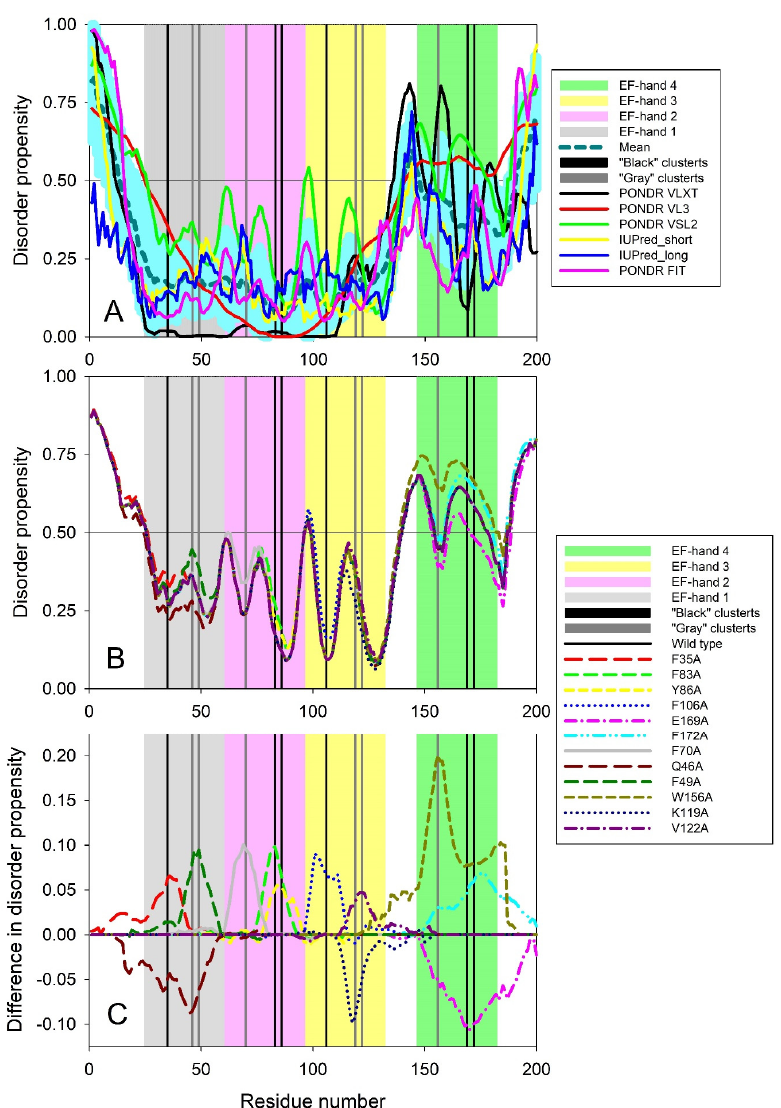
Figure 11. Intrinsic disorder predisposition of human recoverin ( A ) and effect of cluster mutations on intrinsic disorder propensity of this protein ( B , C ). In all plots, positions of four EF-hand motifs, residues 25–60, 61–96, 97–132, and 147–182 are shown by light gray, light pink, light yellow and light green bars, respectively. Positions of all mutations in ‘black’ and ‘gray’ clusters are shown by black and gray bars, respectively. Plot A shows results of a multiparametric analysis of the intrinsic disorder predisposition of human recoverin (UniProt ID: P35243) with several commonly used disorder predictors. X -axis shows the positions of the amino acids, whereas Y -axis represents the intrinsic disorder propensity of a given amino acid. Disorder profiles generated by PONDR ® VLXT, PONDR ® VL3, PONDR ® VSL2, PONDR ® FIT, and IUPred_short and IUPred_long are shown by black, red, green, pink, yellow, and blue lines, respectively. Thick dashed dark cyan line shows the mean disorder propensity calculated by averaging disorder profiles of individual predictors. Light cyan shadow around the mean disorder curve shows error distribution. In these analyses, the predicted intrinsic disorder scores above 0.5 are considered to correspond to the disordered residues / regions, whereas regions with the disorder scores between 0.2 and 0.5 are considered flexible. Plot B represents the PONDR ® VSL2-generated intrinsic disorder profiles of human recoverin protein and all its cluster mutants in a form of the per-residue mean disorder propensity calculated for each protein. Plot C shows “difference disorder spectra” calculated by subtracting PONDR ® VSL2-generated disorder profile of the wild type human recoverin from the mean disorder profiles of individual cluster